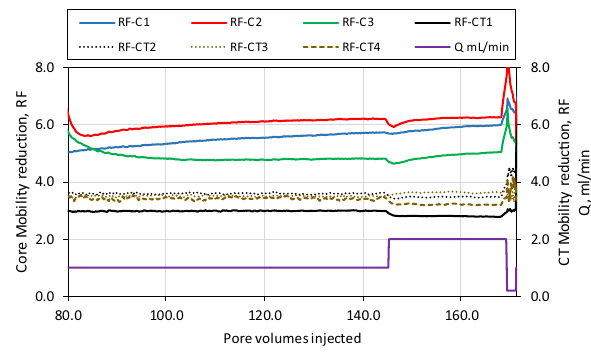
Fig. 3 Experiment 1a. 1000 ppm A06 in SSW in Bentheimer. Dif- ferential pressure across cores and capillary tubes as a function of pore volumes injected in Core 1 (C1 at 20 °C), Core 2 (C2 at 30 °C), Core 3 (C3 at 60 °C). Number of pore volumes injected is calculated from the pore volume of Core 1